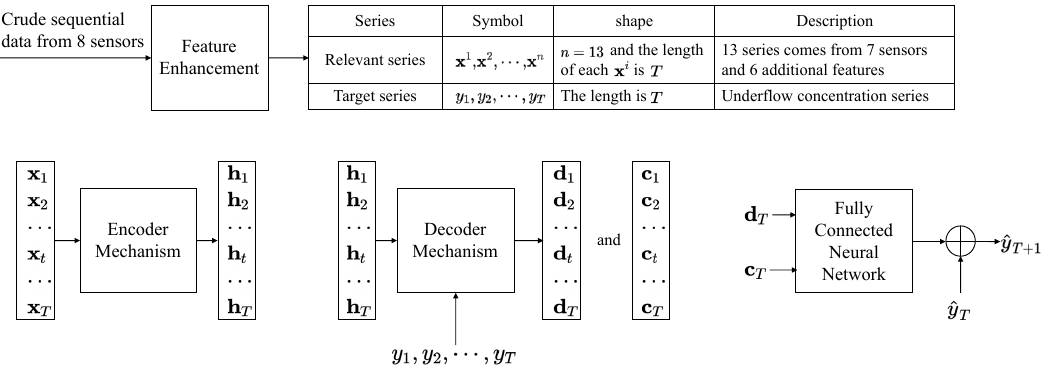
Figure 2. The proposed model is mainly composed four parts: Feature Enhancement, Encoder mechanism, Decoder mechanism, and a normal neural network for predicting. Feature Enhancement explores additional 6 features based on industrial experience. The left three learnable parts are connected in a chain to give the prediction and train